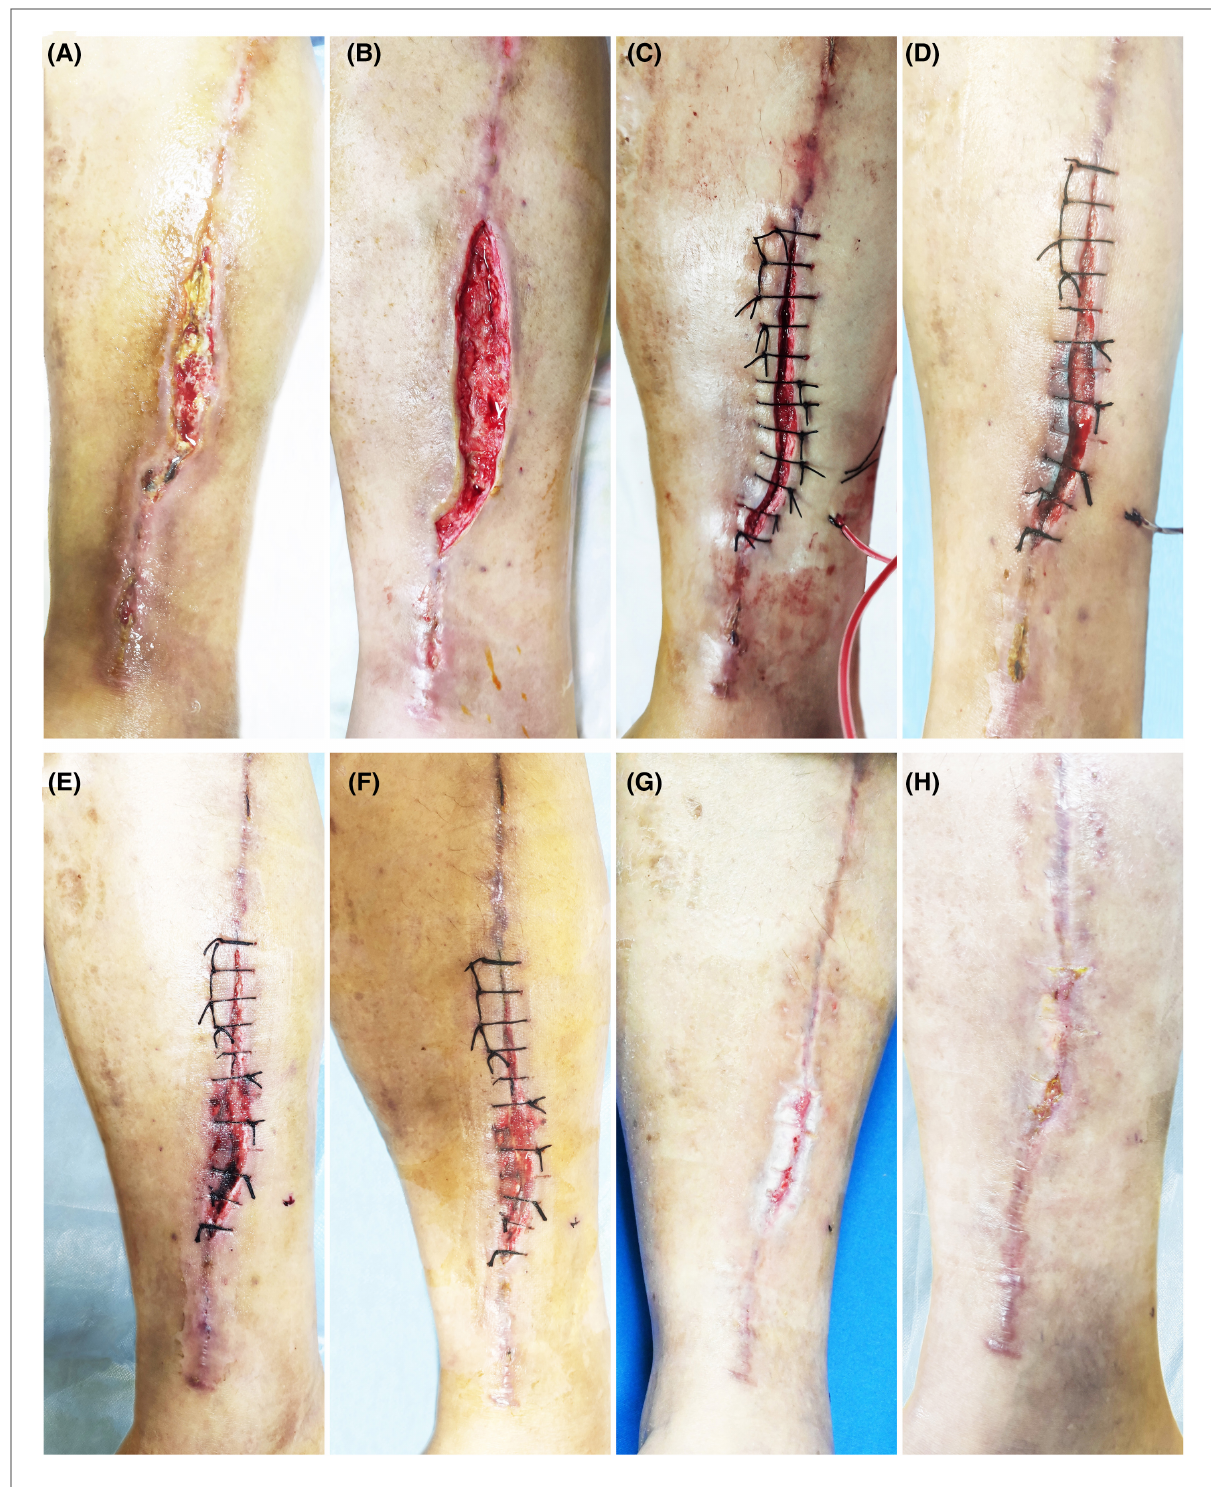
FIGURE 4 Patient 4. A 52-year-old male suffered a chronic wound on the medial side of his lower leg after undergoing a great saphenous vein graft . ( A ) Baseline. ( B ) Treatment day. The wound was clean after debridement. ( C ) Treatment day. The wound was sutured with silk thread, and then PRP was injected into the wound bed and the PRF was fi lled in the wound. ( D ) The second day after the treatment. ( E ) 3 days after the treatment. ( F ) 7 days after the treatment. ( G ) 14 days after the treatment. ( H ) 3 months after the